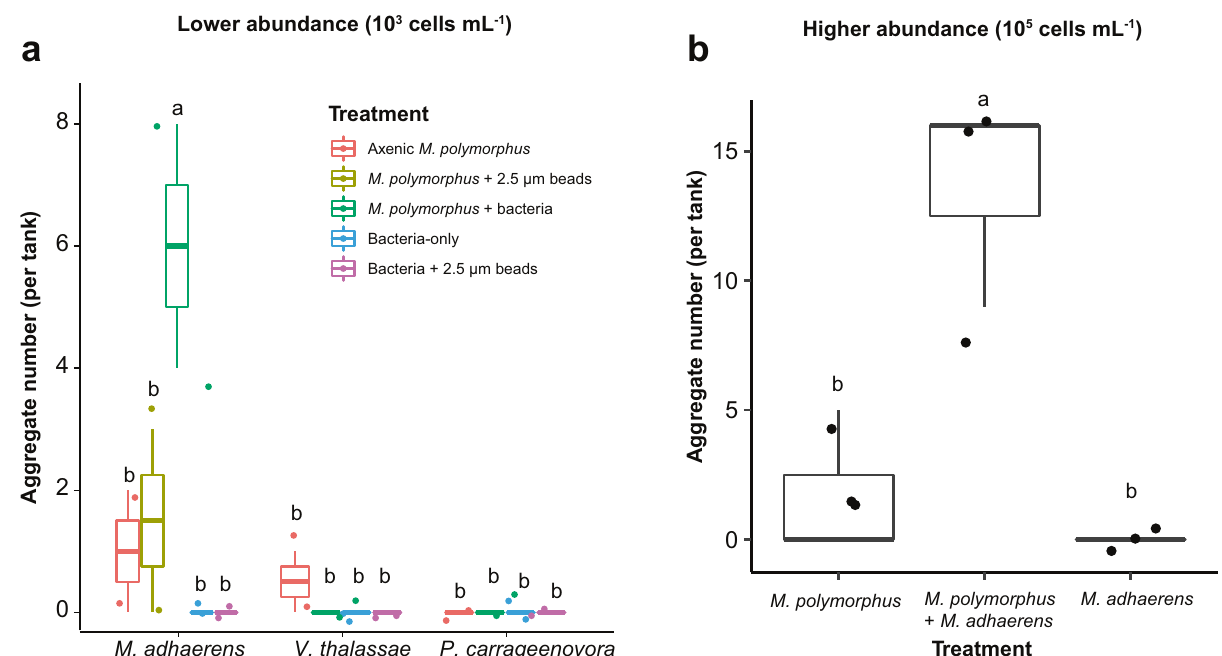
Fig. 4 Aggregation of Minutocellus polymorphus in roller tanks with and without the addition of Marinobacter adhaerens HP15, Vibrio thalassae , or Pseudoalteromonas carrageenovora . Number of visible sinking aggregates formed in roller tanks with axenic Minutocellus polymorphus , and M. polymorphus with the addition of 2.5 µm silica beads , Marinobacter adhaerens HP15, Vibrio thalassae , or Pseudoalteromonas carrageenovora in the low cell abundance experiments ( a ca. 10 3 cells mL − 1 ; Table 3) and of axenic M. polymorphus and M. polymorphus with the addition of M. adhaerens in the high cell abundance experiments ( b 10 5 cells mL − 1 ; Table 4). Lowercase letters indicate signi fi cant differences between treatments.